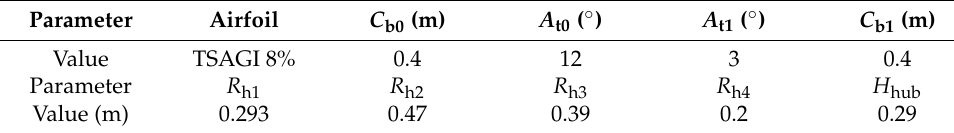
Table 2. Main dimensions of rotor 1.